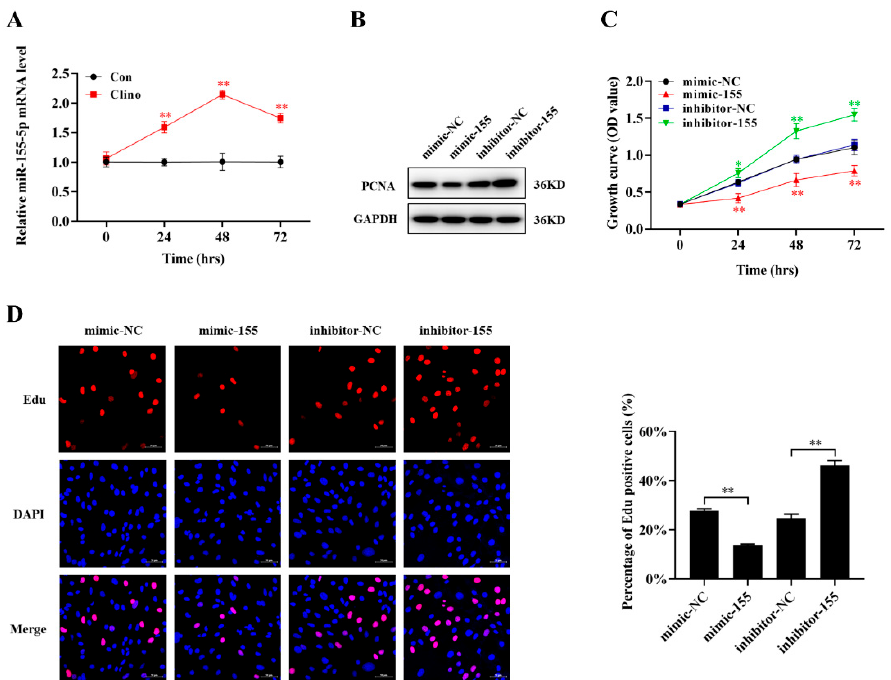
Figure 4. The miR-155-5p inhibits microvascular endothelial cell proliferation. ( A ) miR-155-5p mRNA level was analyzed by qRT-PCR in microvascular endothelial cells that were cultured under clinorotation conditions at 24–72 h (N = 3). ( B ) The protein expression of PCNA in microvascular endothelial cells was analyzed by Western blotting (N = 3). ( C ) Cell proliferation was evaluated by CCK-8 assay (N = 3). The symbol *(Red) represents the mimic-NC vs. mimic-155 group; the symbol *(Green) represents the inhibitor-NC vs. inhibitor-155 group. ( D ) Proliferating microvascular endothelial cells were labeled with EdU (N = 3). Scale bar, 50 µm. * p < 0.05, ** p < 0.01 vs. control.